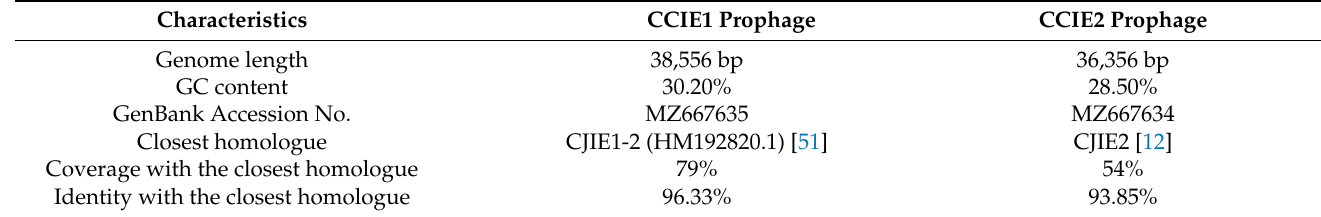
Table 2. General characterization of the newly identified CCIE1 and CCIE2